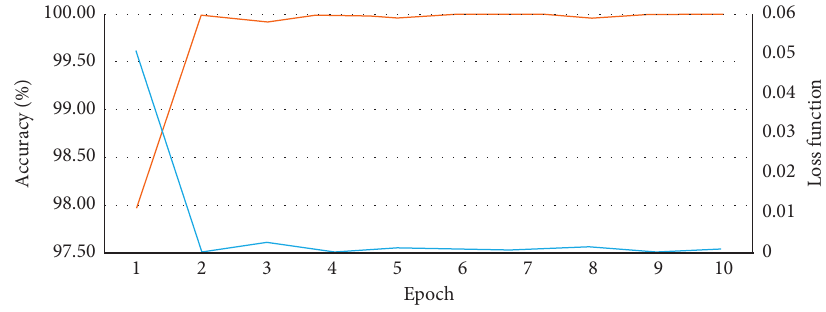
Figure 13: Ten-fold cross-validation result of bearing dataset. Table 3: Classification results for the gearbox dataset. Fault diagnosis method